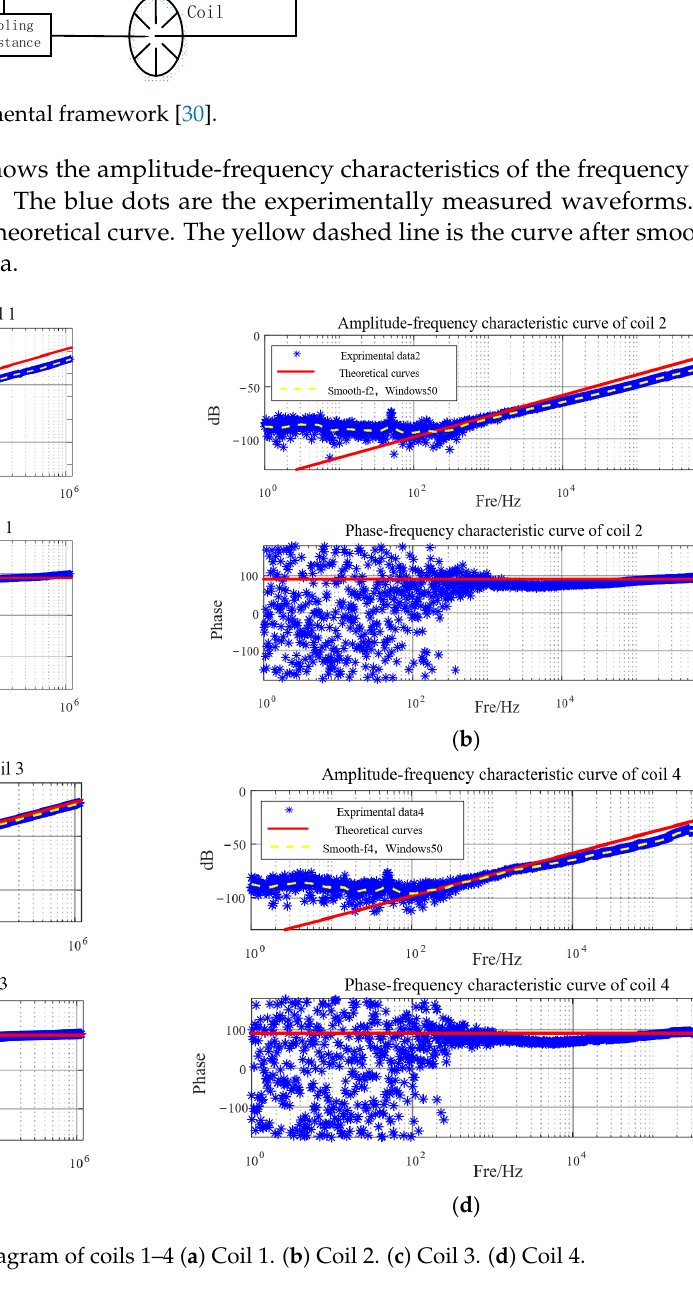
Figure 11. Experimental framework [30].